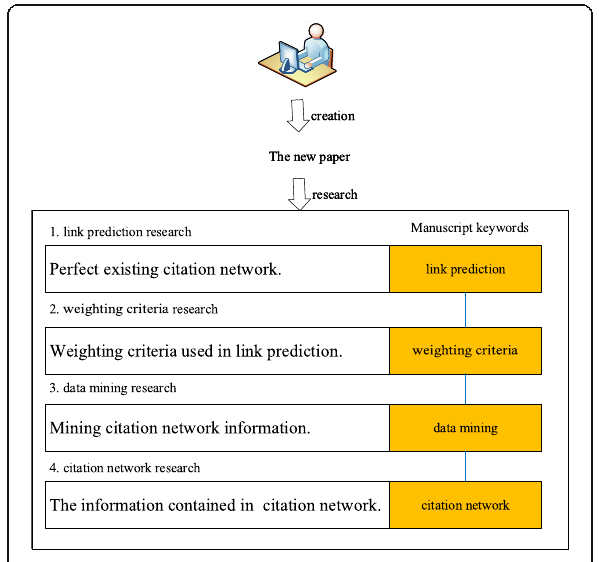
Fig. 1 An example of paper keywords